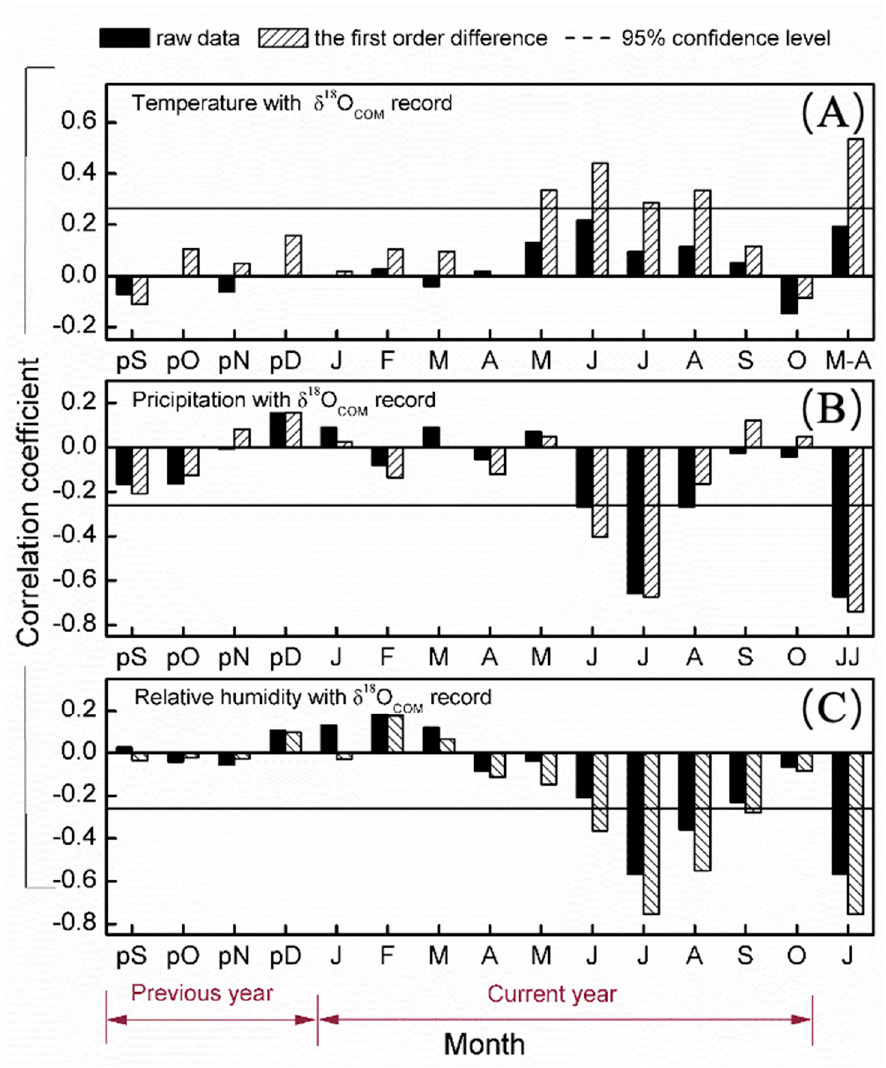
Figure 4. Correlations between tree ring δ 18 O tree chronology and climatic factors. ( A ) Mean monthly temperature. ( B ) Total monthly precipitation. ( C ) Mean relative humidity. M ‒ A: May ‒ August; JJ: June ‒ July.